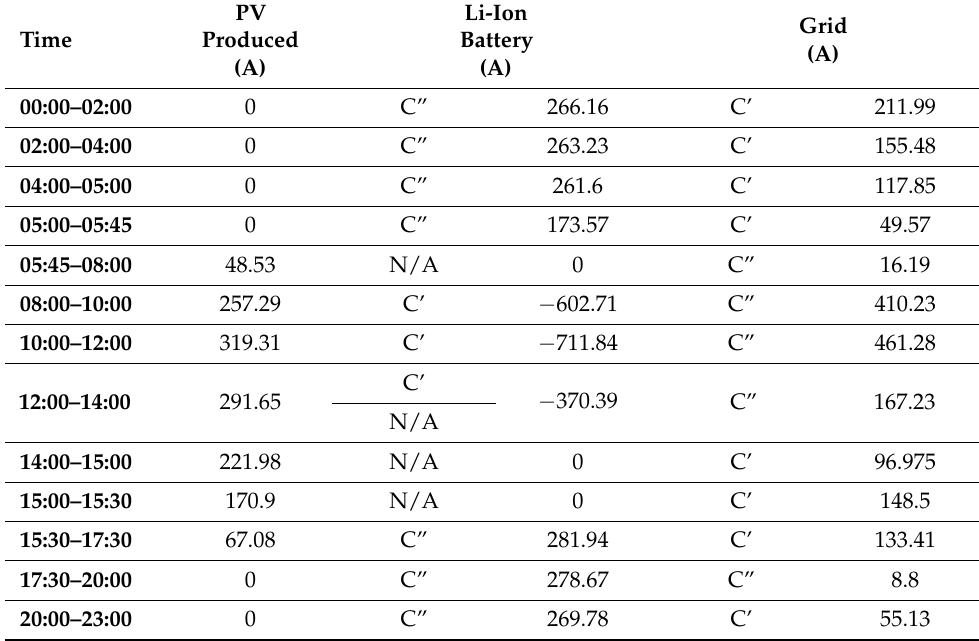
Table 5. Behaviour of power system electric resources (Li-ion).